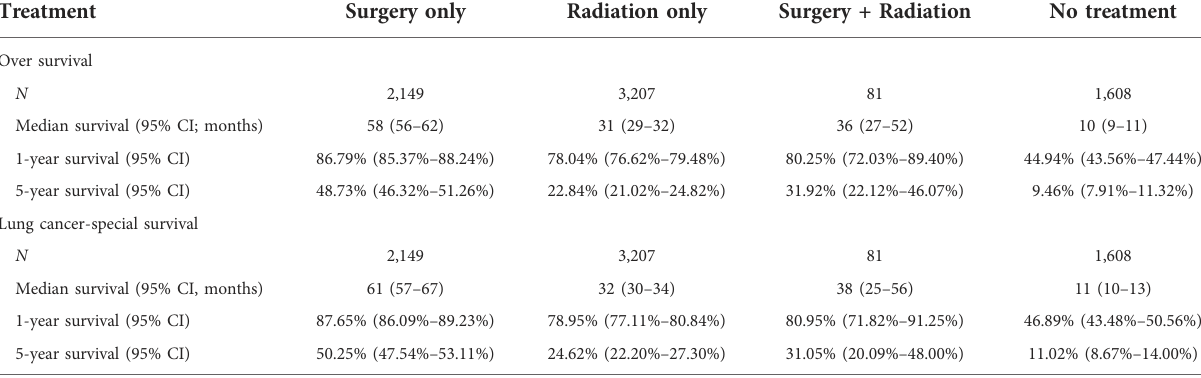
TABLE 4 Overall survival and lung cancer-speci fi c survival for people treated using different methods. Treatment Surgery only Radiation only Surgery +